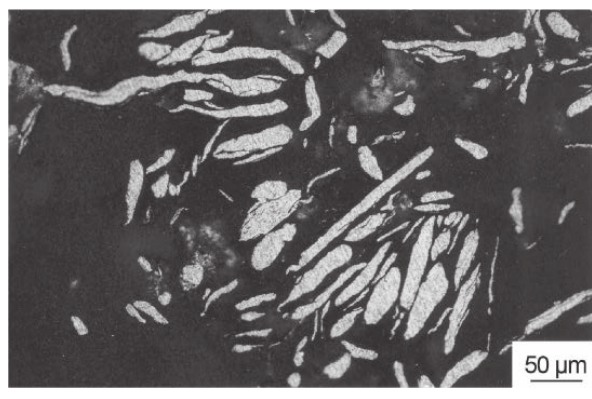
Fig. 3: State of granules after 10 min milling of Al + 1C material